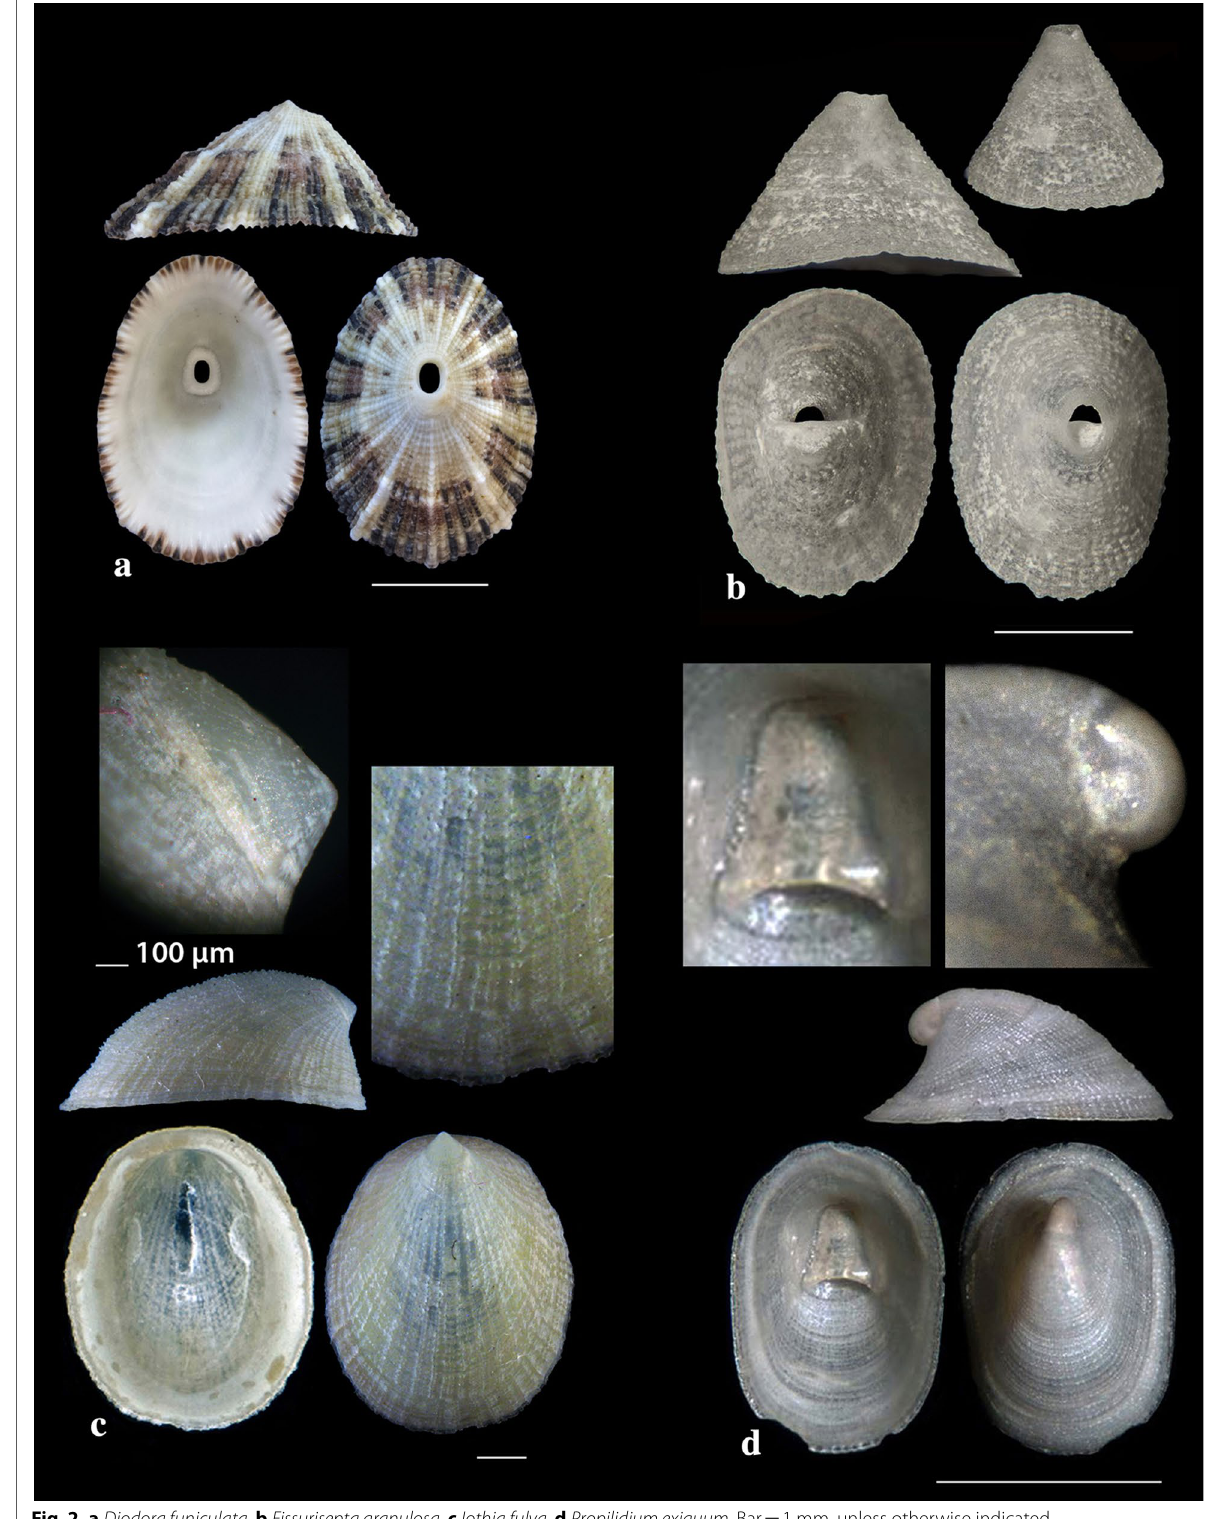
Fig. 2 a Diodora funiculata , b Fissurisepta granulosa , c Iothia fulva , d Propilidium exiguum . Bar